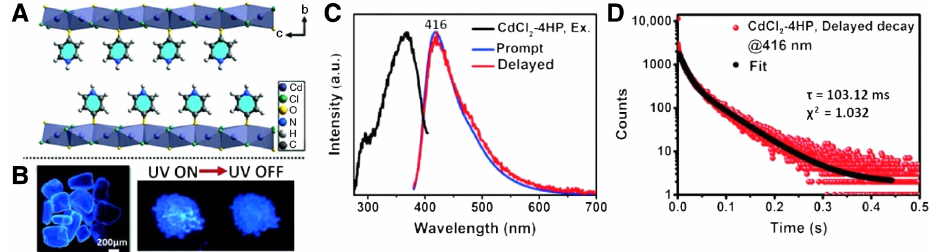
-4HP perovskite crystals. Figure 11: Delayed fluorescence of CdCl 2 (A) The crystal structure and (B) the fluorescence microscopy images of the CdCl line) PL spectra of CdCl -4HP excited under 365 nm at room temperature. (D) The time-resolved PL decay profiles (416 nm) of CdCl 2